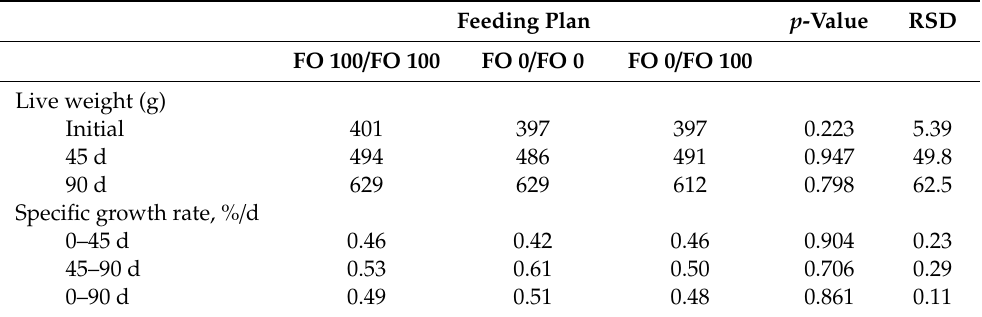
Table 1. Growth performance of S. dumerili during the wash-out period. Values are expressed as least square (LS)